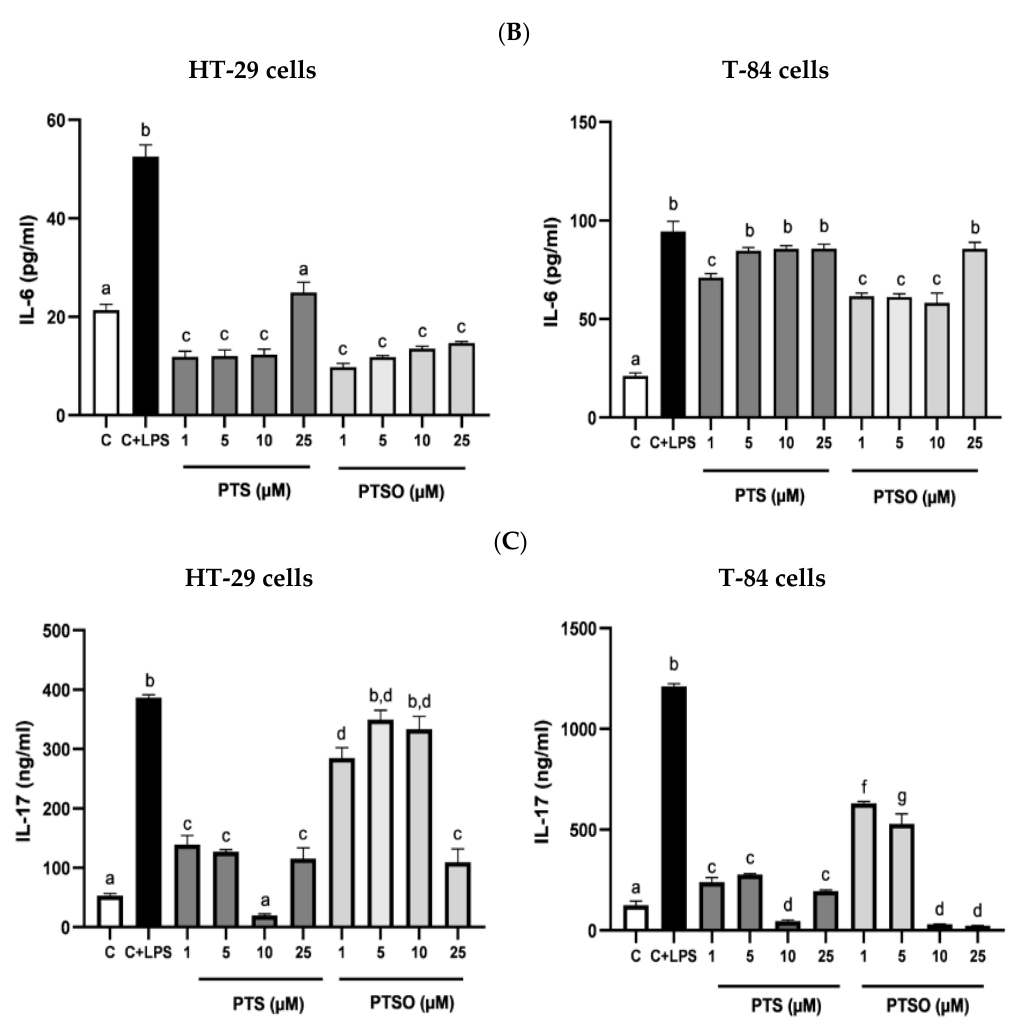
Figure 5. Effect of PTS and PTSO on inflammatory status. ( A ) Impact of PTS and PTSO on IL-8 concentration in HT-29 cells (a) and T-84 cells (b) induced with LPS. ( B ) Effect of both treatments on IL-6 concentration in HT-29 cells (a) and T-84 cells (b) induced with LPS. Cells were induced during 24 h with LPS (1 µg/mL) and increasing concentrations of PTS and PTSO (1 – 25 µM). ( C ) Evaluation of PTS and PTSO on IL-17 concentration in HT-29 cells and T-84 cells induced with LPS. C = cells not induced with LPS (control), C + LPS: cells induced with only LPS (1 µg/mL). Different letters between columns indicate significant differences at p < 0.05.